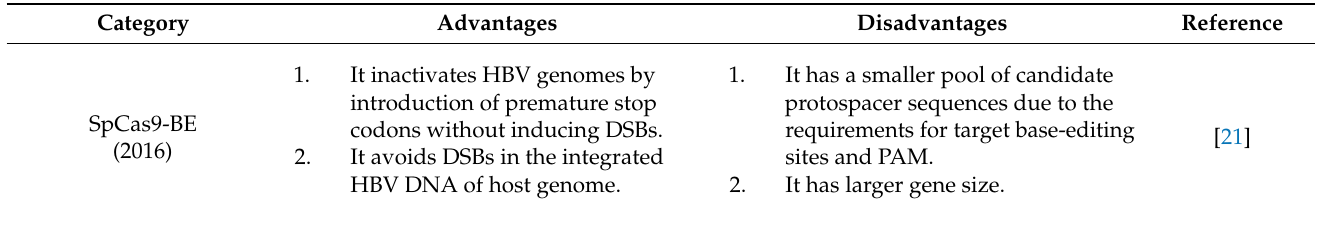
Table 2. Engineered or new Cas9 variants that have been applied for HBV